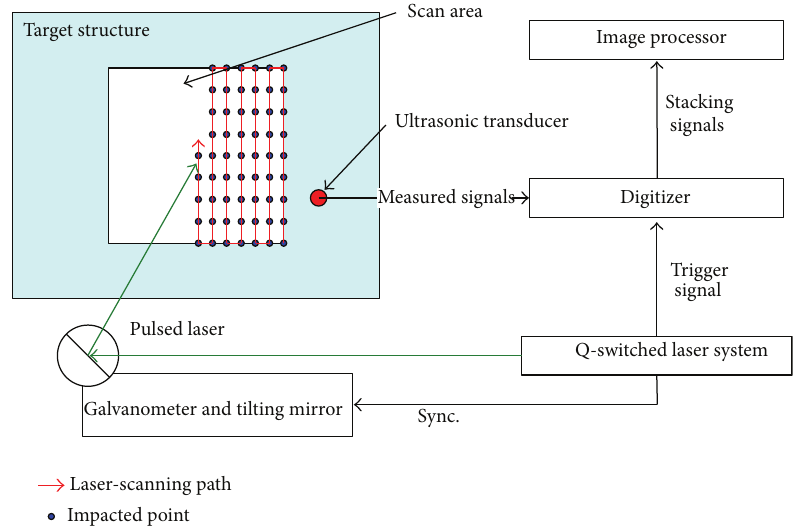
Figure 1: A scheme of an ultrasonic wave propagation imaging system based on a UWPI laser system.